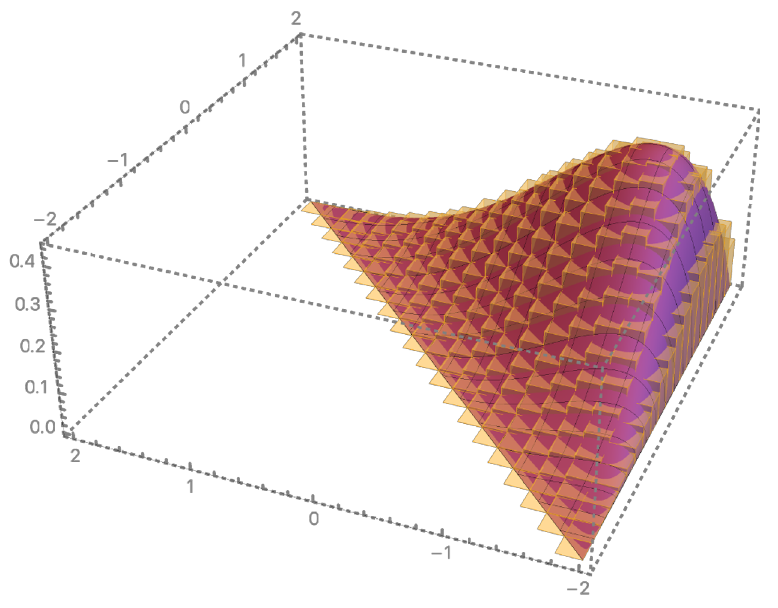
Figure 23 . An overlay of the histogram and function p 2 h from the previous